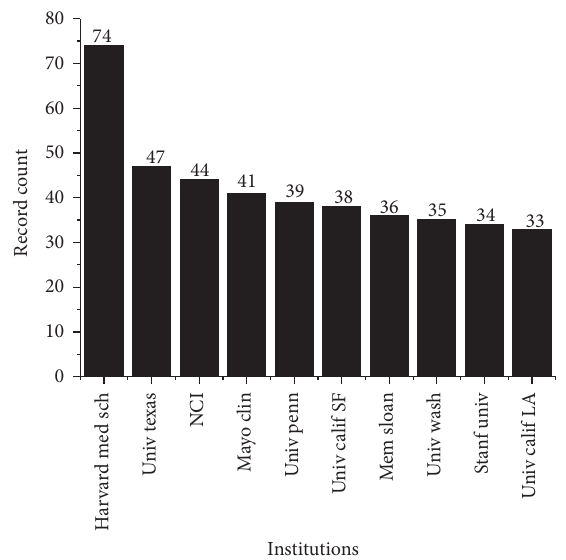
Figure 13: Main institutions responsible for scientific publications.